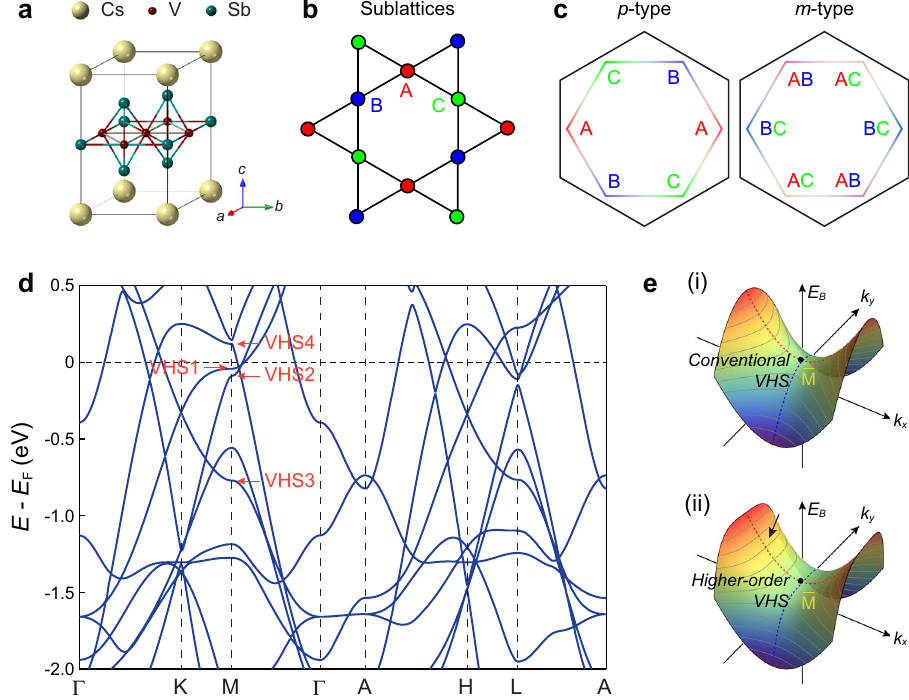
Fig. 1 Crystal structure, Kagome sublattices and van Hove singularities in kagome superconductors CsV 3 Sb 5 . a The Lattice structure of kagome metals CsV 3 Sb 5 . b Real space structure of the kagome vanadium planes. The red, blue, and green coloring indicate the three kagome sublattices. c Two distinct types of sublattice decorated van Hove singularities (VHSs) in CsV 3 Sb 5 , labeled as p-type (sublattice pure, left panel) and m-type (sublattice mixing, right panel). d Density functional theory calculated electronic structure of CsV 3 Sb 5 . The red arrows mark the VHSs. e Schematics of the conventional VHS (i) and higher-order VHS (ii) in two-dimensional electron systems. The gray curves in ( e ) indicate the constant energy contours that show markedly fl at features along the k y direction in higher-order VHS, as highlighted by the black